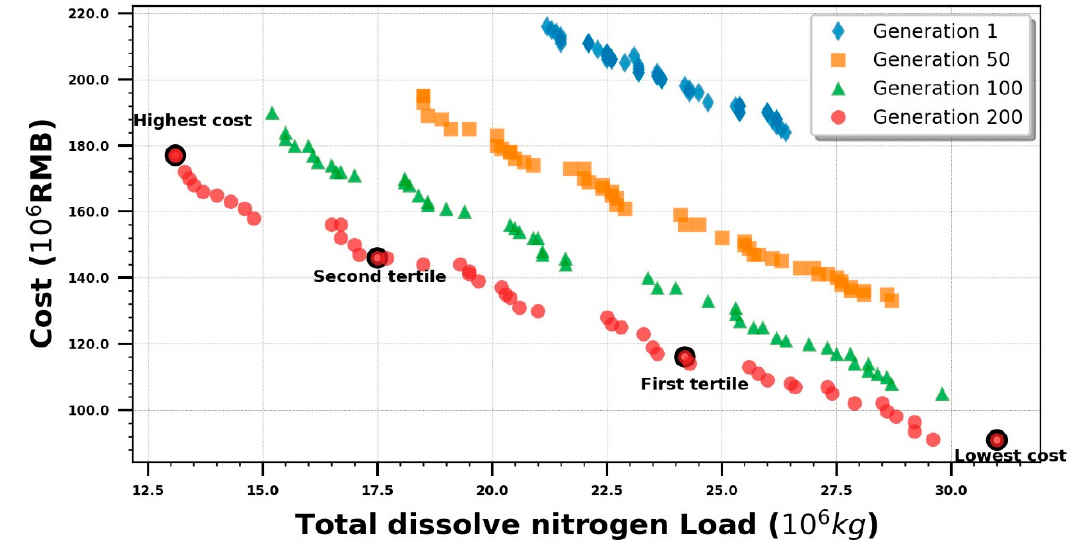
Figure 6. Pareto-optimal fronts for total dissolved nitrogen load and cost.